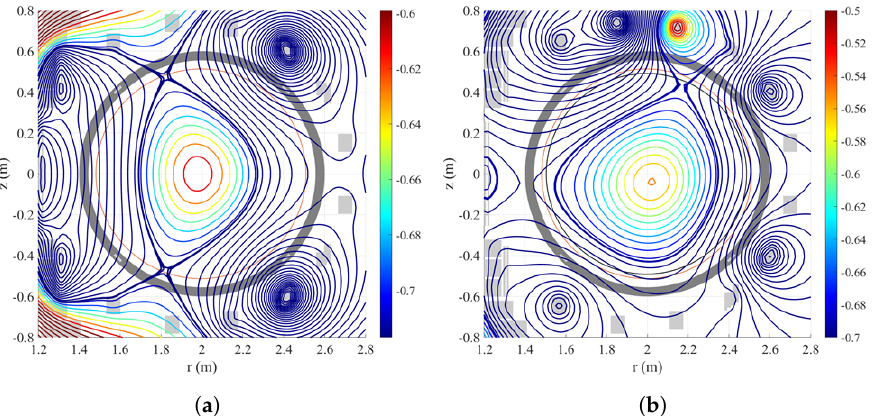
Figure 1. ( a ) Double Null D-like shape with δ = δ u = δ l = 0.49. ( b ) Upper Single Null shape with δ = − 0.35 ( δ u = − 0.54, δ l = −